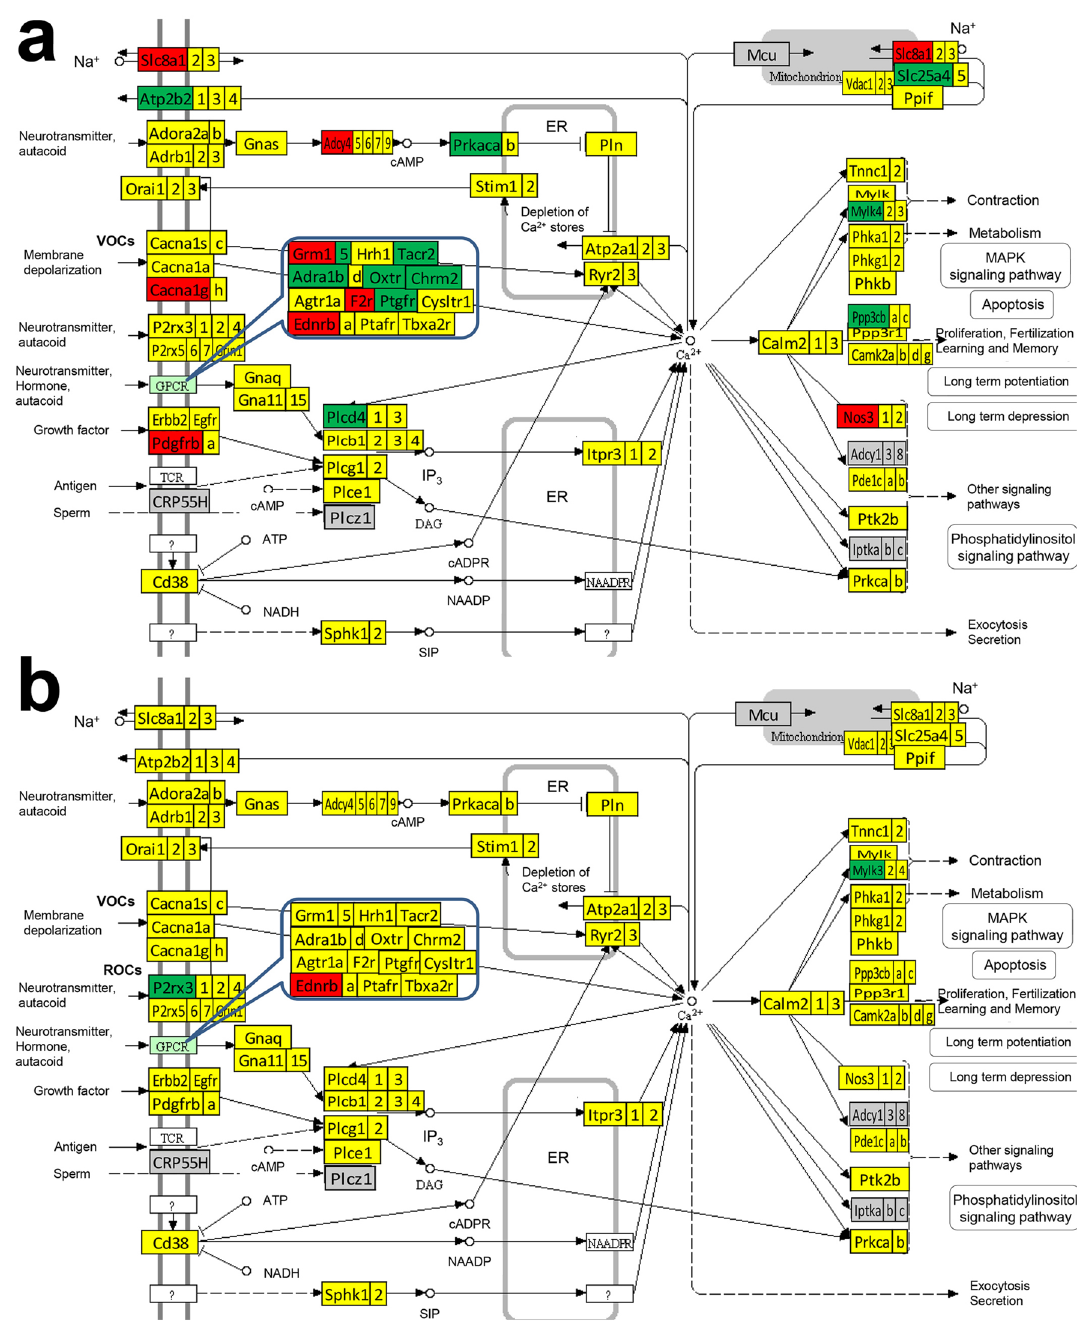
Figure 5. KEGG map ( modified from https ://www.genom e.jp/dbget -bin/www_bget?mmu04 020) of the differential expression of calcium signaling (CAS) genes in: ( a ) the right atrium with respect to the left atrium, ( b ) right ventricle vs left ventricle. Red/green/yellow background of the gene symbol indicates up-/ down-/not regulated. Not quantified genes are on grey background. Genes with significant differences: Adcy4 , adrenergic receptors ( Adra1b ), Atp2b2 , Cacna1g, cholinergic receptor muscarinic 2 cardiac ( Chrm2 ), endothelin receptor type B ( Ednrb ), coagulation factor II (thrombin) receptor ( F2r ), metabotropic glutamate receptors ( Grm1, Grm5 ), myosin light chain kinase ( Mylk4 ), nitric oxide synthase ( Nos3 ), oxytocin receptor ( Oxtr ), purinergic receptor P2X ligand-gated ion channel 3 ( P2rx3 ), platelet derived growth factor receptor ( Pdgfrb ), phospholipase ( Plcd4 ), protein phosphatase 3, catalytic subunit, beta isoform ( Ppp3cb ), protein kinase cAMP dependent catalytic alpha ( Prkac a), prostaglandin F receptor ( Ptgfr ), solute carriers ( Slc25a4 , Slc8a1 ), tachykinin receptor 2 ( Tacr2